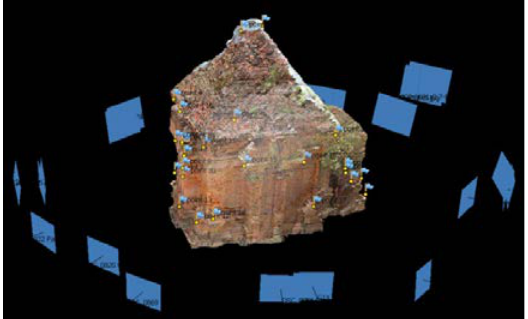
Figure 15. Po Dam Tower, the achieved 3D textured model by Photoscan Agisoft (SfM)